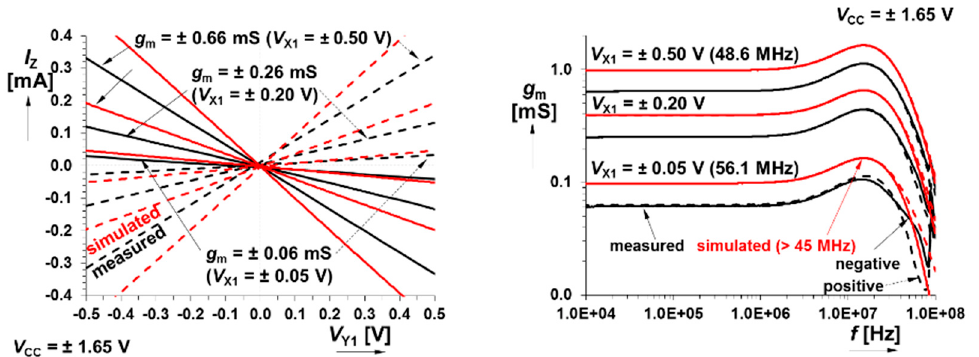
Figure 7. Selected results of the measured and simulated responses of the CMOS MLT: (left) DC transfer responses Y 1 → Z for a V X1 controlled by DC voltage; (right) magnitude of AC transfer responses Y 1 → Z for a V X1 controlled by DC voltage.